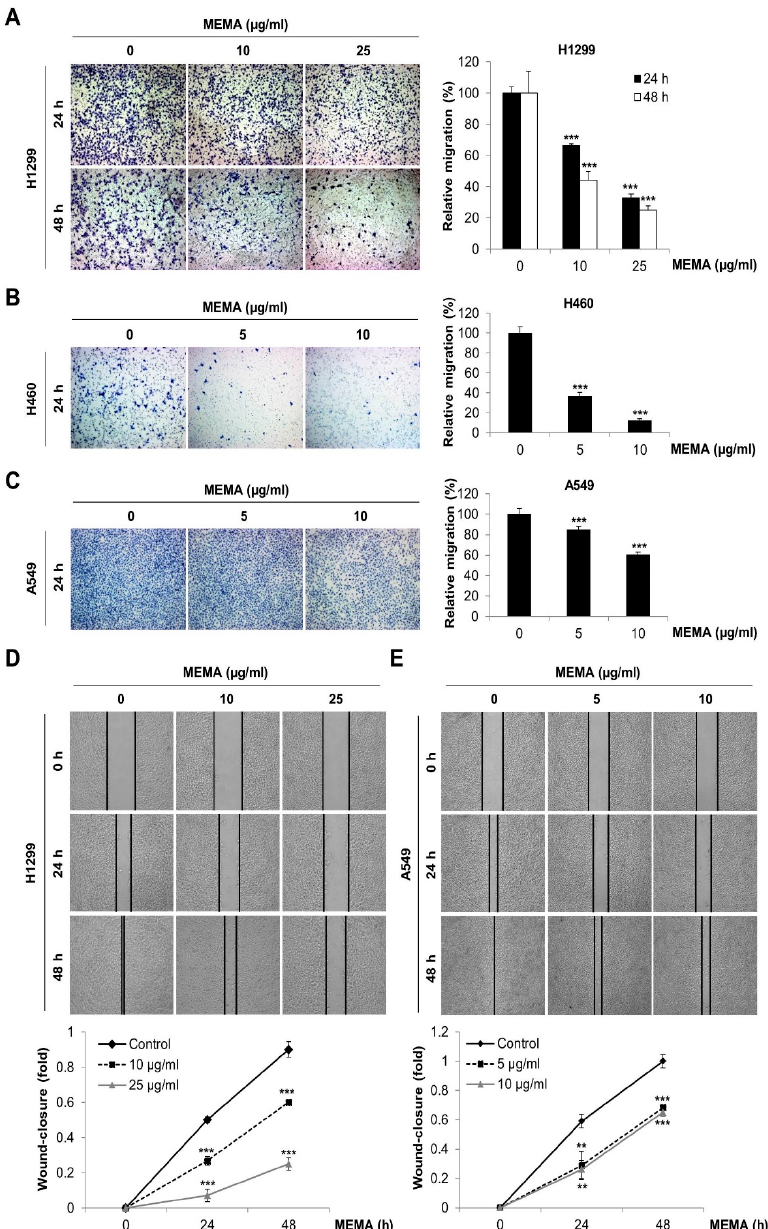
Figure 3. Effects of MEMA on the migration of human NSCLC cells. ( A – C ) Transwell migration assay was performed in H1299 ( A ), H460 ( B ), and A549 ( C ) cells. Cells were plated into the gelatin-coated upper chambers of a 24-well format transwell plate and treated with MEMA. Ten percent FBS medium was added in lower chamber as a chemoattractant. After 24 h or 48 h of incubation, the migrated cells were stained and photographed under microscope (100 × magnification). The representative fields of three independent experiments are shown (left panel). The relative migration was calculated by counting the number of stained cells (right panel). ( D , E ) H1299 ( D ) and A549 ( E ) were seeded onto 6-well plates and the confluent cell layer was scratched with a yellow tip. Then the cells were treated with MEMA in serum-free medium ( D ) or 2% FBS medium ( E ). The wound closure was monitored under microscope during 48 h and photographs were taken at 0 h, 24 h, and 48 h after wound generation (50 × magnification). The representative fields of three independent experiments are shown (upper panel), and the wound closure was calculated (lower panel). The data are expressed as the mean ± SD of three independent experiments. Significance was determined by the Student’s t -test (** p < 0.01, *** p < 0.001 versus untreated